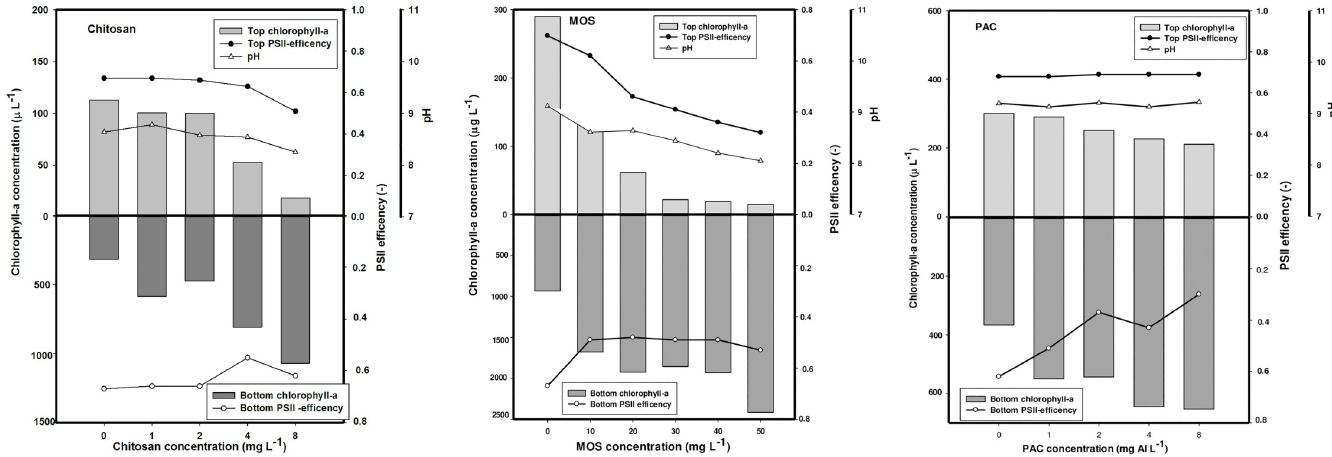
Fig 2. Cyanobacterial removal efficiency of different flocculants in floc and sink experiment. Chlorophyll- a concentrations ( μ g/ L) in the top 2 mL (top light gray bars) and bottom 2 mL (lower dark gray bars) of cyanobacteria suspensions incubated for 1 h with different concentrations of flocculants: A) chitosan B) MOS & C) PAC. For chitosan, MOS and PAC series, open triangle represents the pH value. Closed and open circle represents the top and bottom PSII efficiency values.